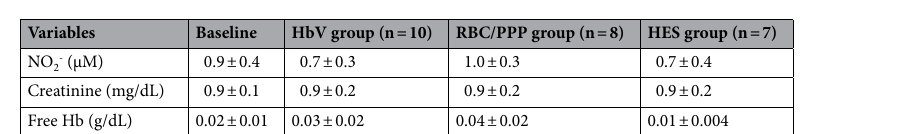
Table 4. Plasma levels of nitric oxide, creatinine, and free Hb at 60 min by group. Data are expressed as the mean ± standard deviation. The HbV group does not show a significant reduction in the NO 2− level. In addition, creatinine levels are maintained within normal ranges. There is also no significant increase in free Hb levels. Hb hemoglobin.